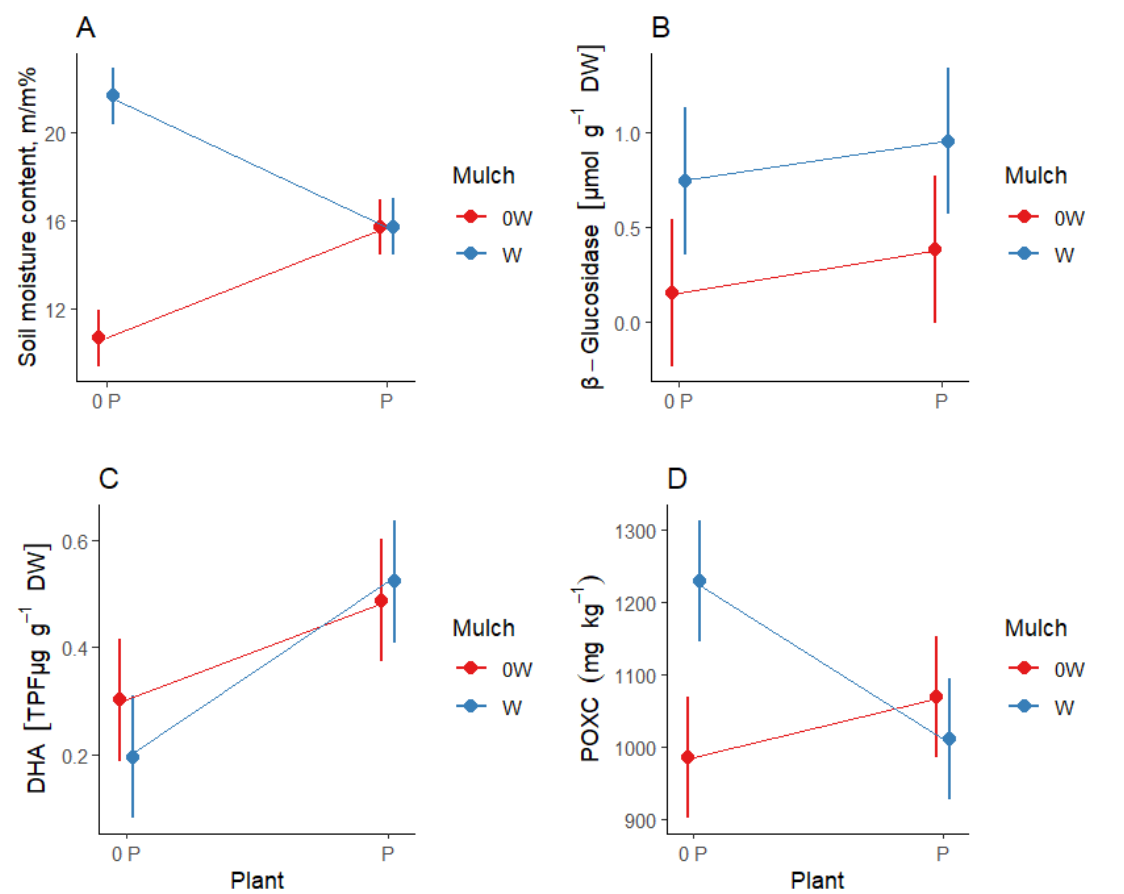
Figure 1. The effect of wool mulch and plant interactions at the Greek site. Interaction diagram showing the combined effect of two factors (mulch and plant; 0P: no plant. P: with plant; 0W: no mulch. W: with wool mulch) on the soil parameters. If there is no interaction, the lines run nearly in parallel. If there is an interaction, there is a difference in terms of the effect that the treatments have on the soil. Random fluctuations can affect the level of parallelism. If the figure seems to contradict the p -values that are associated with the interaction, prioritize taking the p -values into